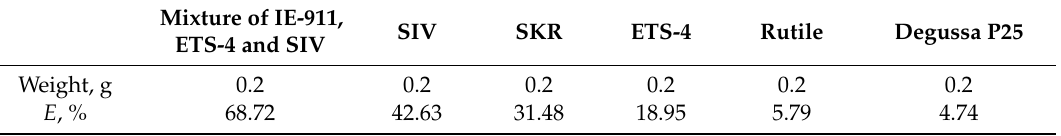
Table 5. Photochemical activity of mineral-like titanosilicates and titanates under visible